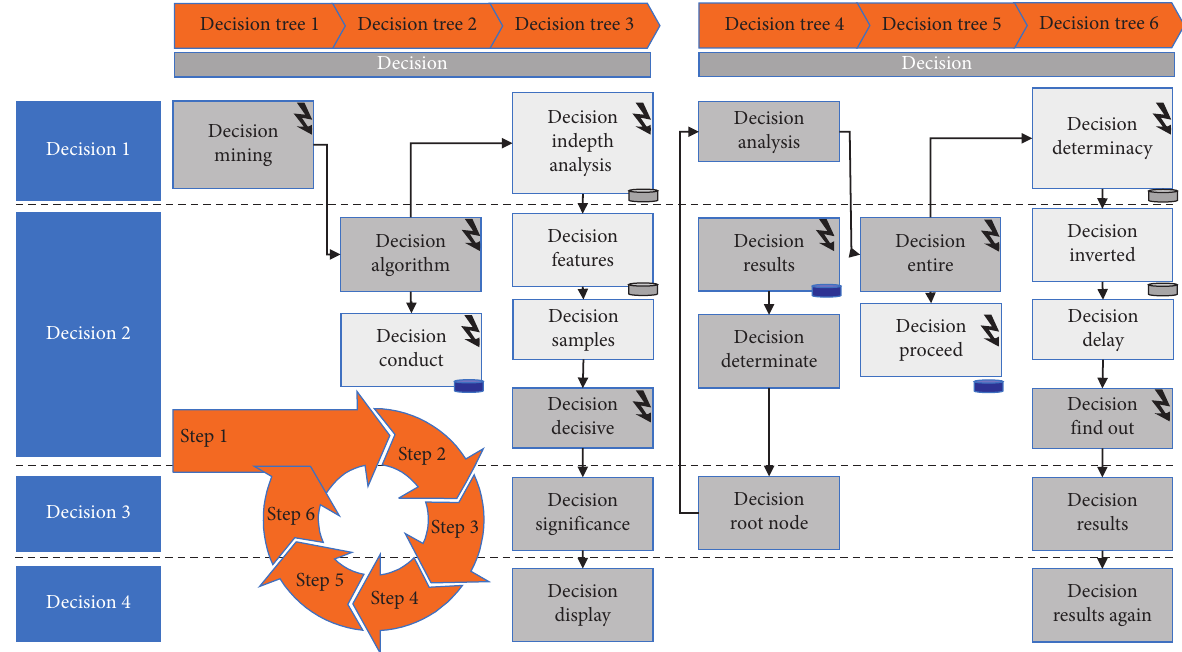
Figure 1: The processing model of the decision tree mining